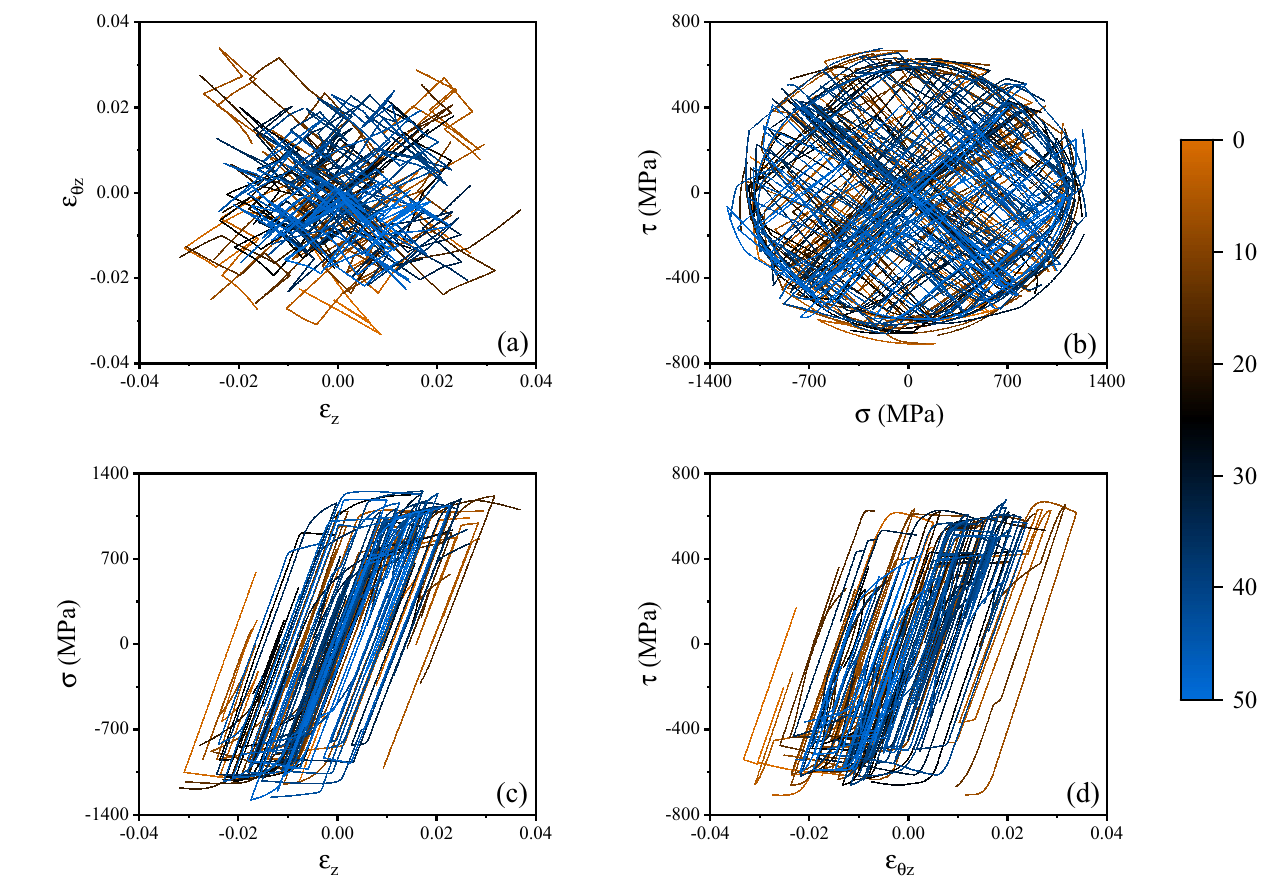
Figure 3. Visualisation of the training dataset ( a ) in strain space; ( b ) in stress space; ( c ) in axial stress versus strain space; ( d ) in shear stress versus strain space. Each of the fifty different loading paths is associated to a different colour according to the colour code displayed on the